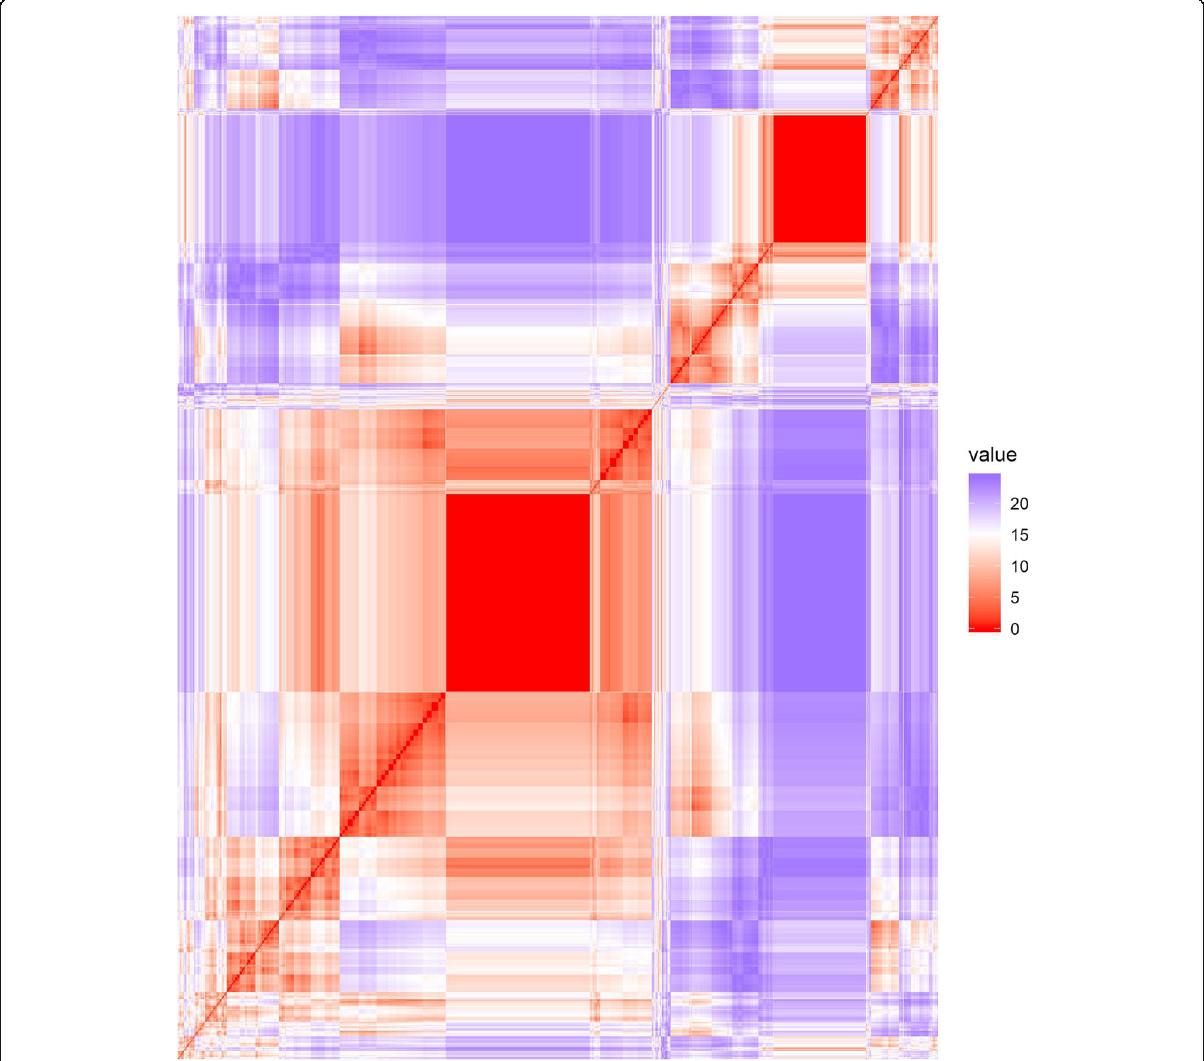
Fig. 2 Heat map of the Euclidean distances of the time series after reduction to the signs of the differenced curve. Two large solid red boxes are present, indicating a number of identical time series (distance=